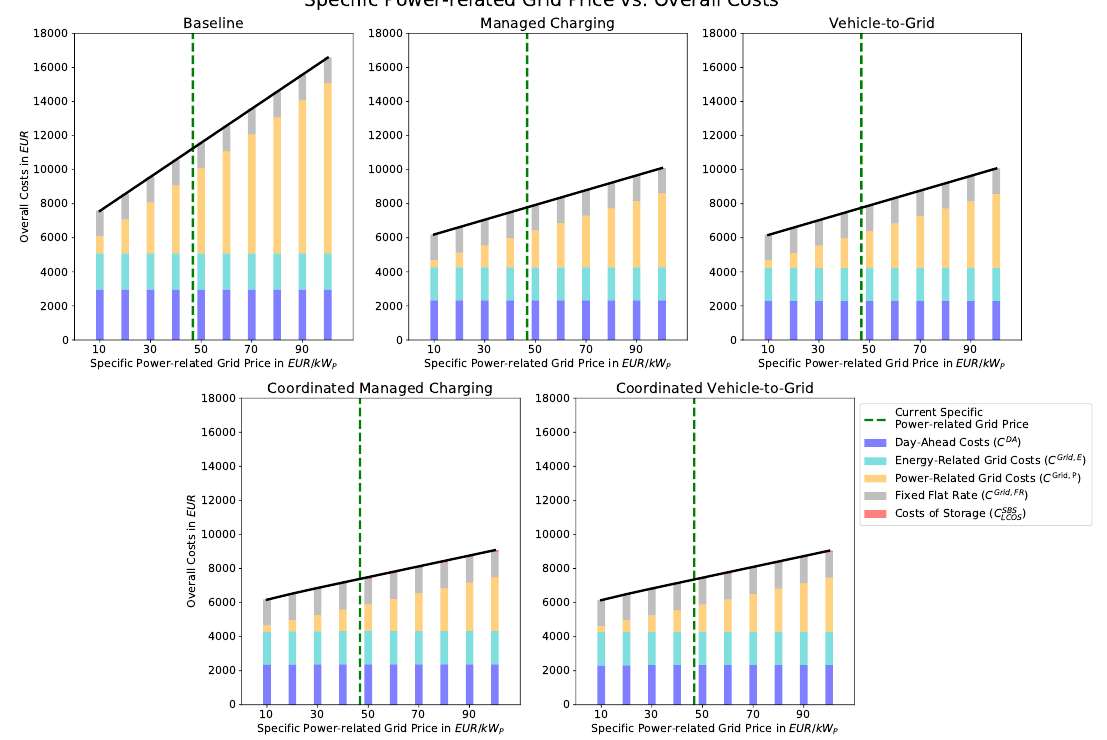
Figure 8. Specific power-related grid price vs. overall